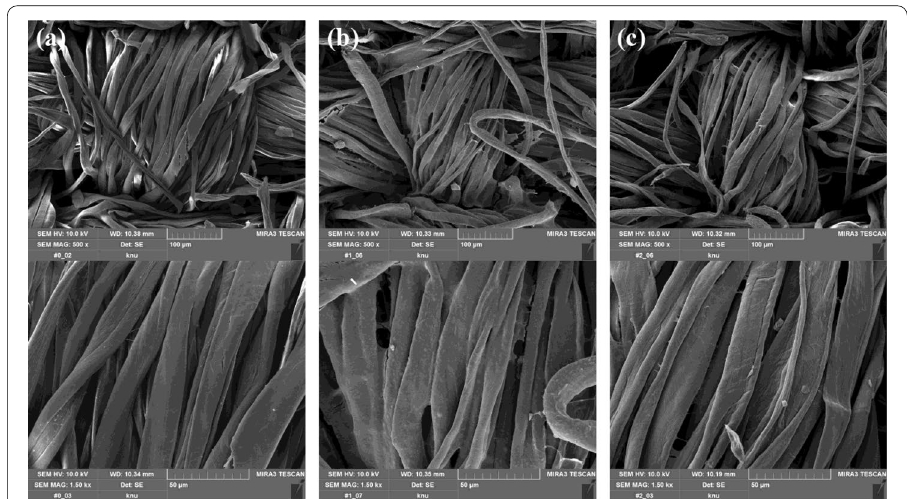
Fig. 4 SEM images of cotton fabrics: a pristine, b gallotannin printed, and c gallotannin printed after five cycles of laundering (magnification: